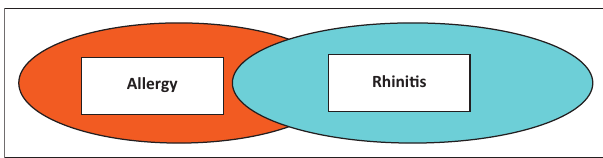
FIGURE 1: Allergic rhinitis = allergy + rhinitis (inflammation of the lining of the nose).